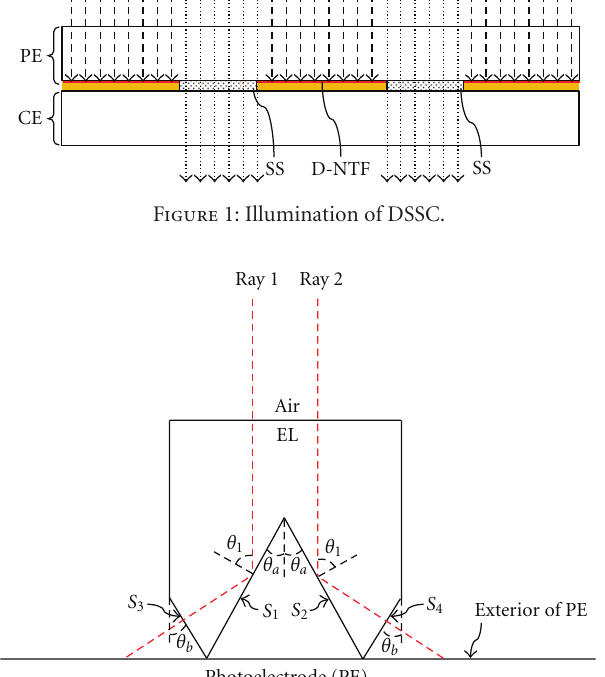
Figure 4: Example of oblique illumination of the EL at an incident angle of θ i